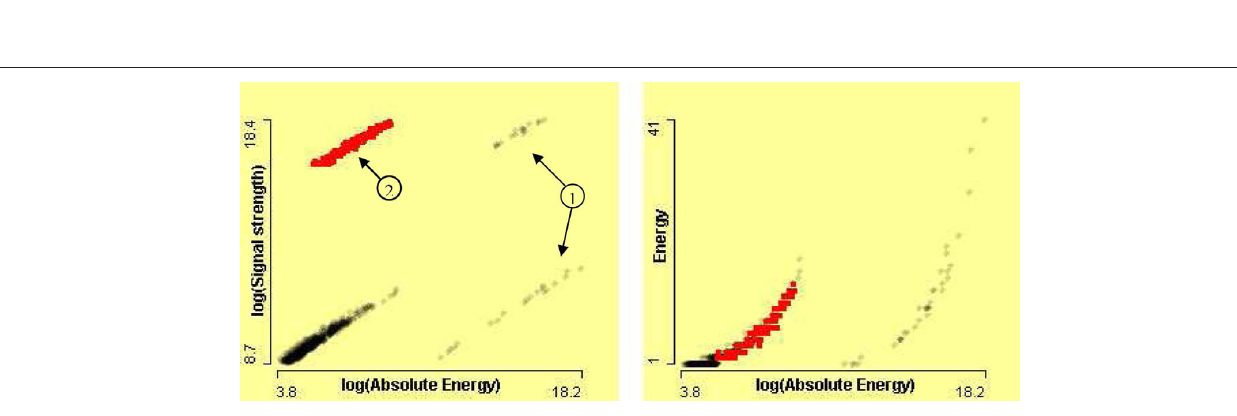
FIgurE 15 | On the left, a scatterplot of Counts by AbsoluteEnergy, and on the right, scatterplot of Amplitude by AbsoluteEnergy , after log transformations.